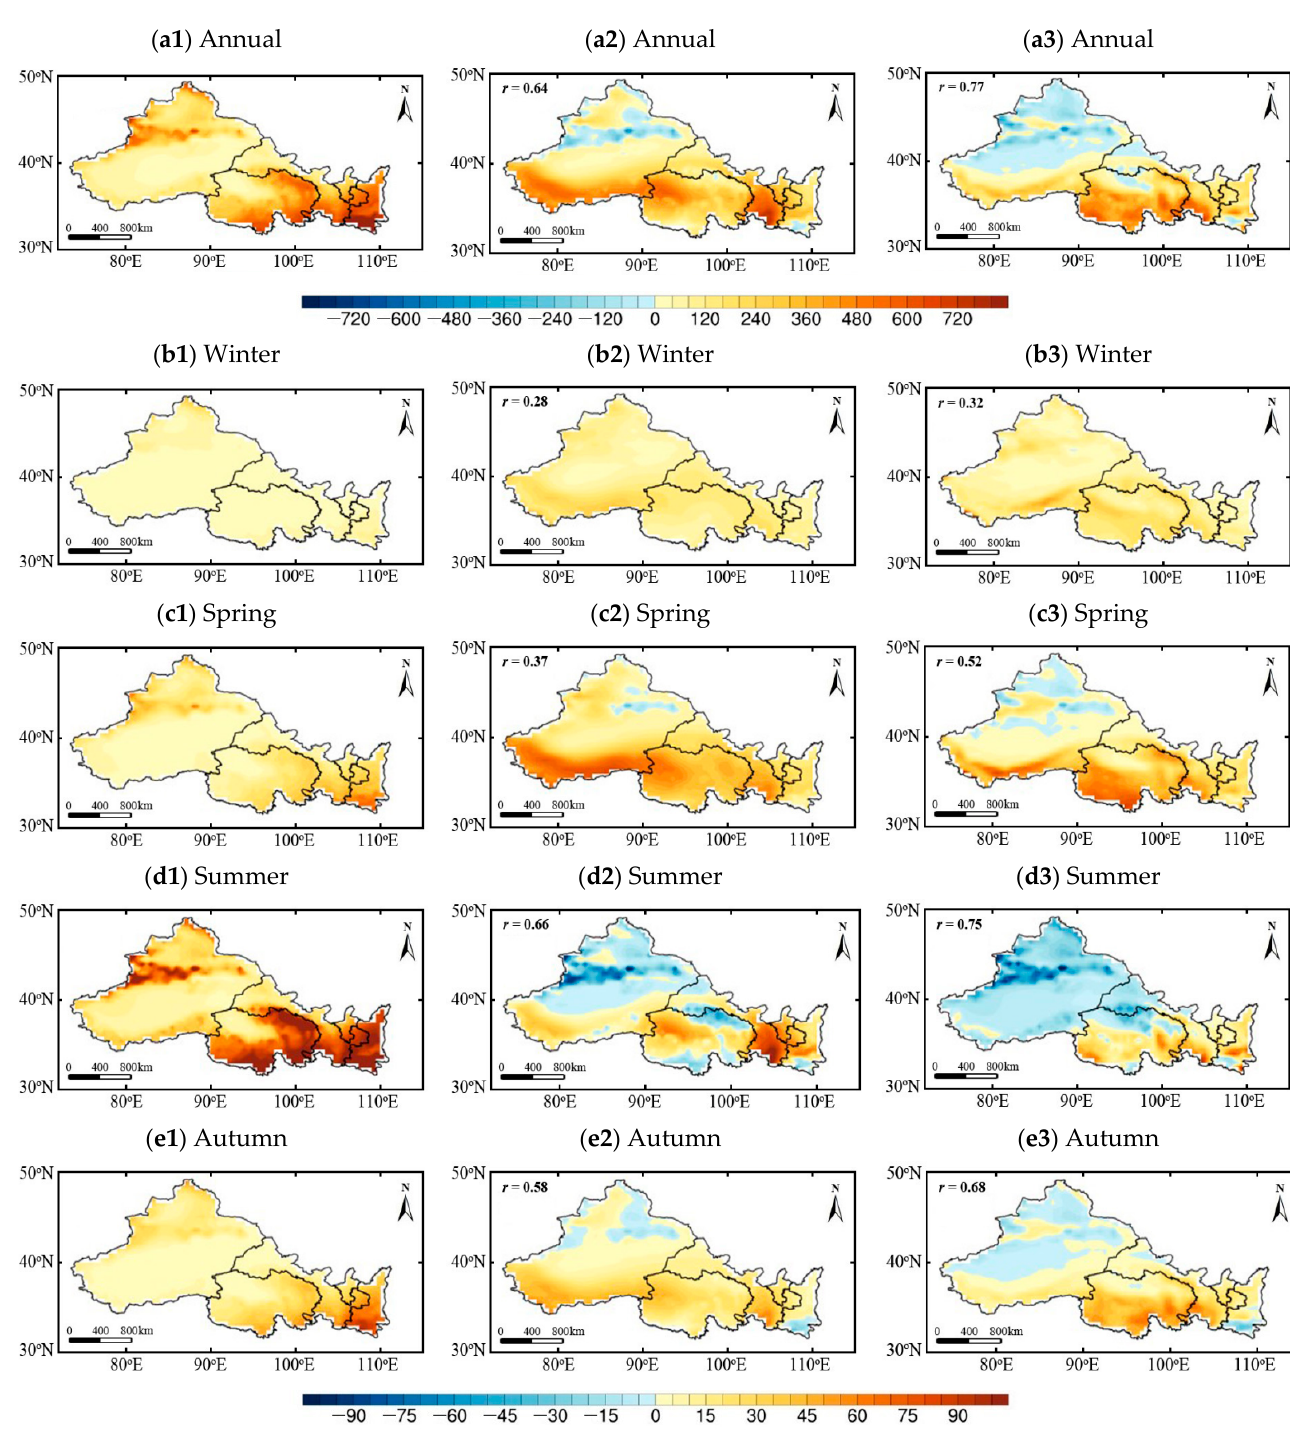
Figure 3. Distribution of precipitation (unit: mm) over Northwest China in different periods during 1961–2014: observations ( left ), and differences between the simulated values of the BCC-CSM2-MR model and the observations ( middle ) and the differences between the simulated values of the BCC-CSM2-HR model and the observations ( right ). r in the upper left indicates the pattern correlation coefficient.